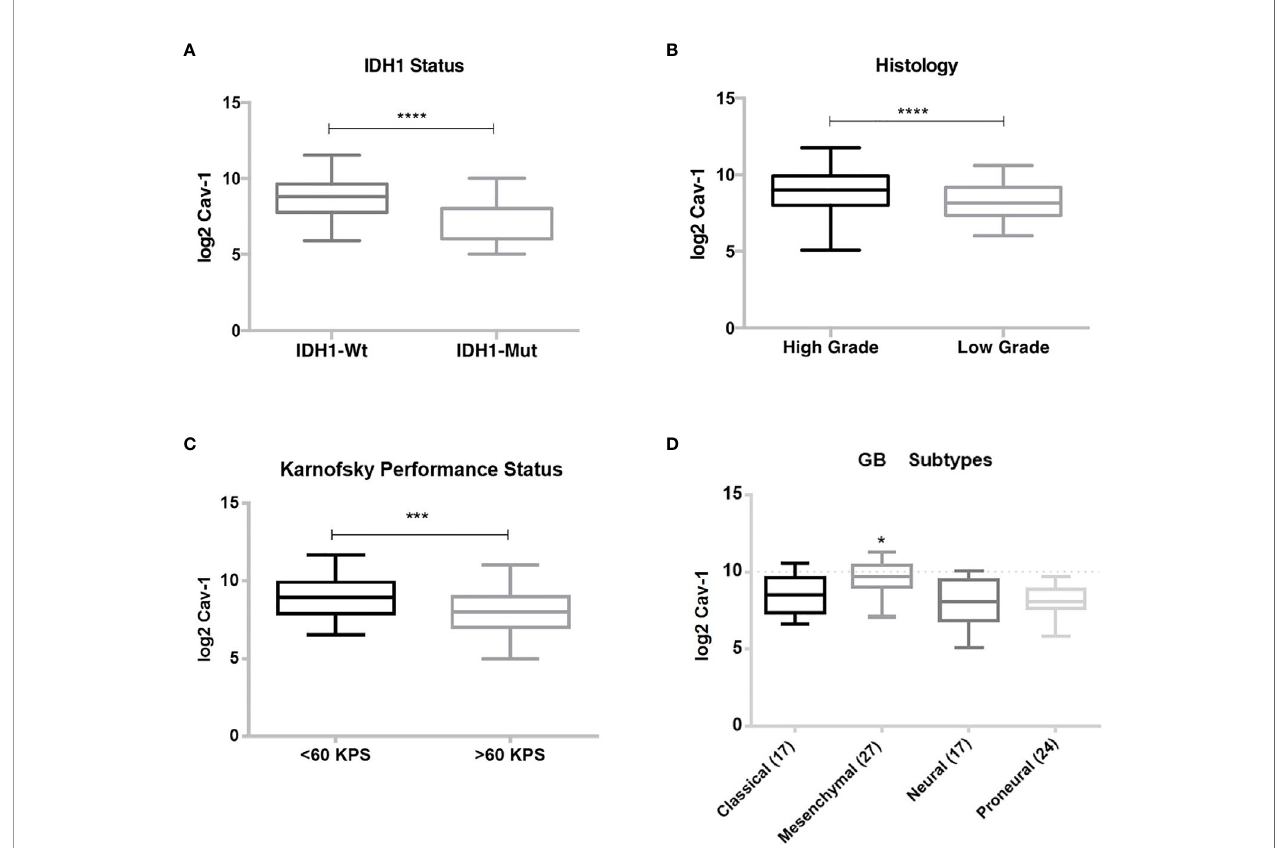
FIGURE 4 | Correlation of Cav-1 tumour expression with prognostic indicators: (A) Isocitrate Dehydrogenase 1 (IDH1) status; (B) Histological grade, Low or High-grade; (C) Karnofsky performance status; (D) Verhaak et al. (5) classi fi cation. Boxes represent median (horizontal line) Cav-1 tumour expression (expressed as log2-fold) and 25th and 75th percentiles (error bars). Data were analysed using Student T-test (unpaired) for comparison of two groups where ***p < 0.0005: ****p < 0.0001. One-way ANOVA and Tukey ’ s test were used for multiple comparisons (GB subgroups) where *p <